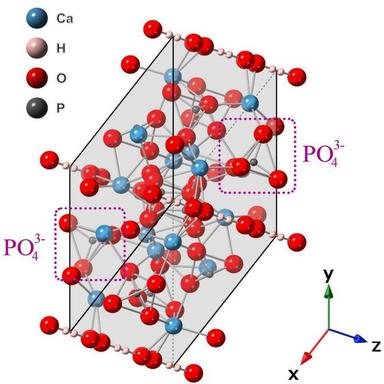
Crystal structure of HAp viewed down the axis, denoting two of the phosphate groups as the only viable sites for the accommodation of germanate. The unit cell of HAp is demarcated in gray.